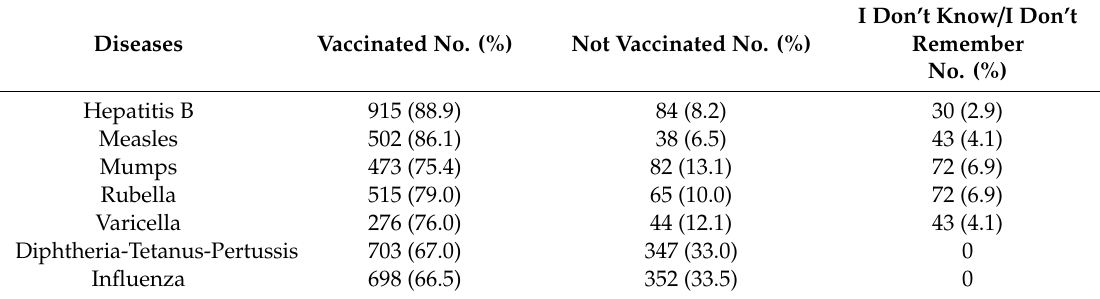
Table 3. Immunization coverage of 1050 PHPs regarding recommended vaccinations for healthcare workers (HCWs).